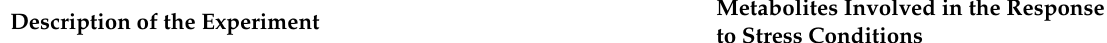
Table 2. Changes in metabolite levels and their correlations with stress resistance. Metabolites involved in responses to heat, drought, salinity, and cold stress in selected crop species identified in the last six years (2017–2022). The changes in the metabolites after exposure to stress are visualized by arrows. Upward-arrow ( ↑ ) means increase and downward-arrow ( ↓ ) means decrease in the metabolite